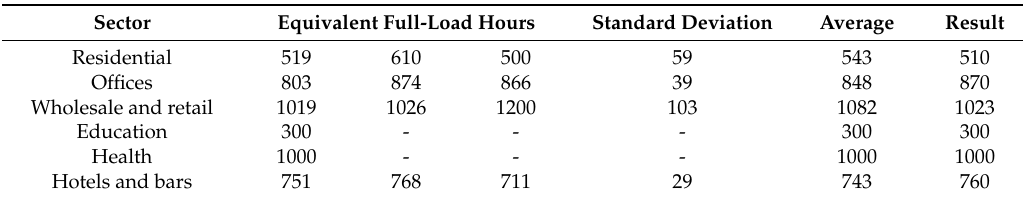
Table A2. Statistical calculations regarding the air-conditioning (AC) equivalent full-load hours per